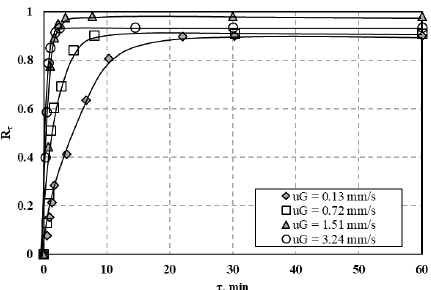
Figure A23. Changes in Cu(II) temporary removal ratio during precipitate flotation from solution containing Al(III), Cu(II), and Zn(II) mixture—effect of air velocity (c 0 = 0.15 mmol dm − 3 , pH = 8.0, c SDS = 0.125 mmol dm − 3 ).